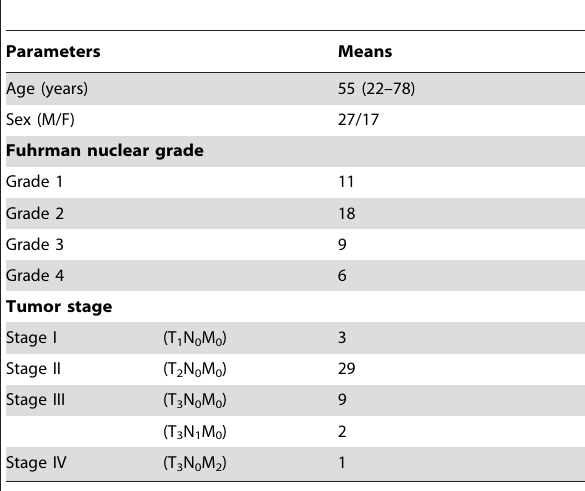
Table 1. Clinical-pathological characteristics of clear cell RCC